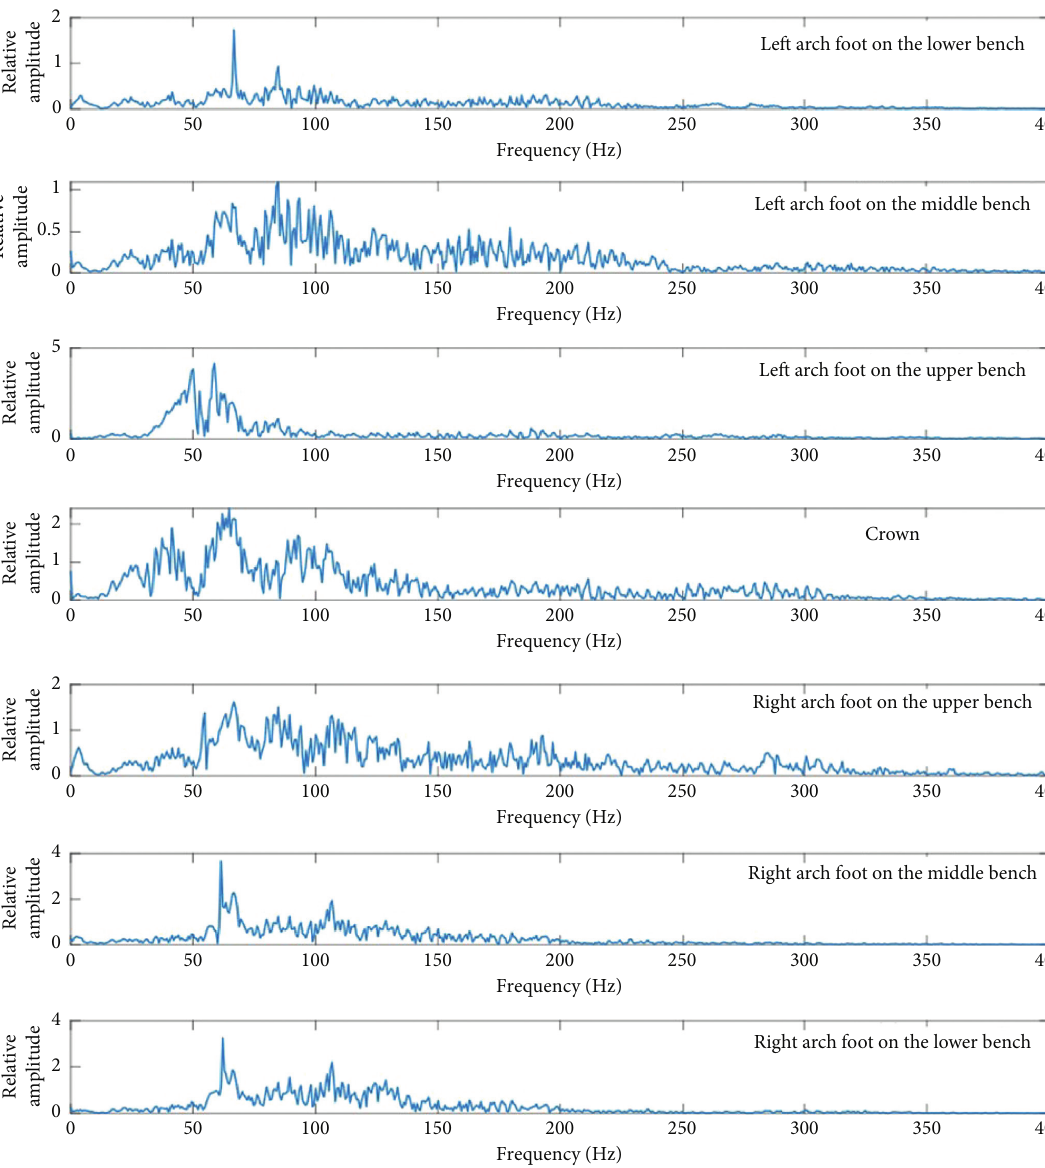
Figure 15: Frequency spectrum of vertical vibration at different positions of tunnel.